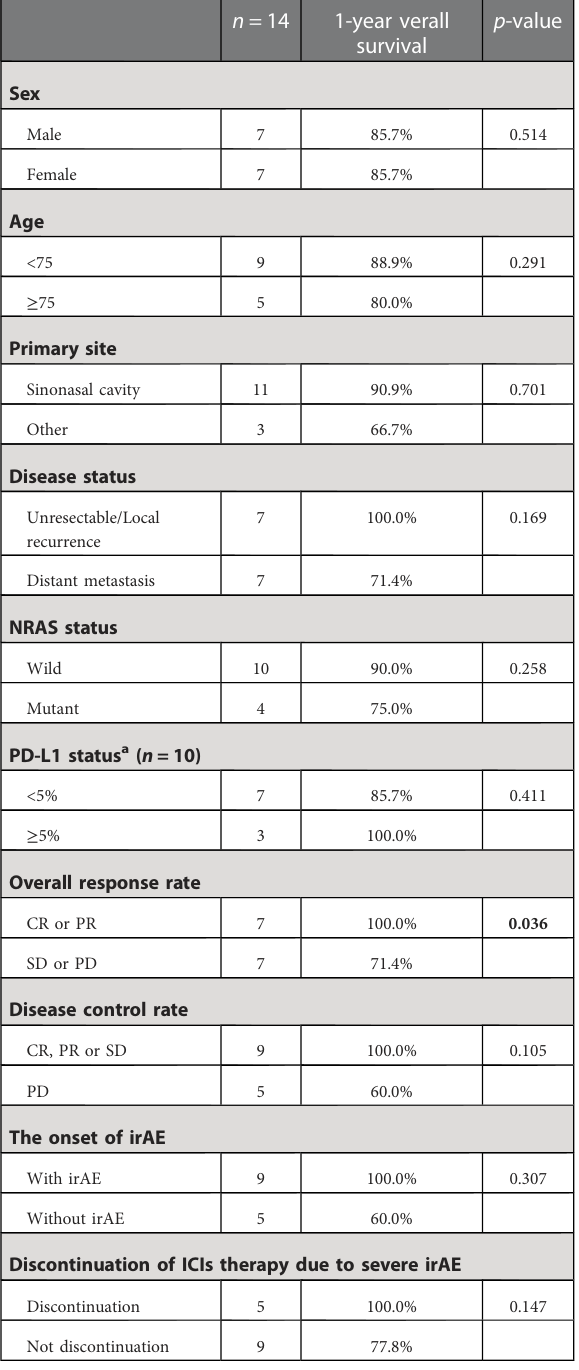
TABLE 4 Univariate analysis of overall survival on patients who received immune checkpoint inhibitors therapy. n = 14 1-year verall